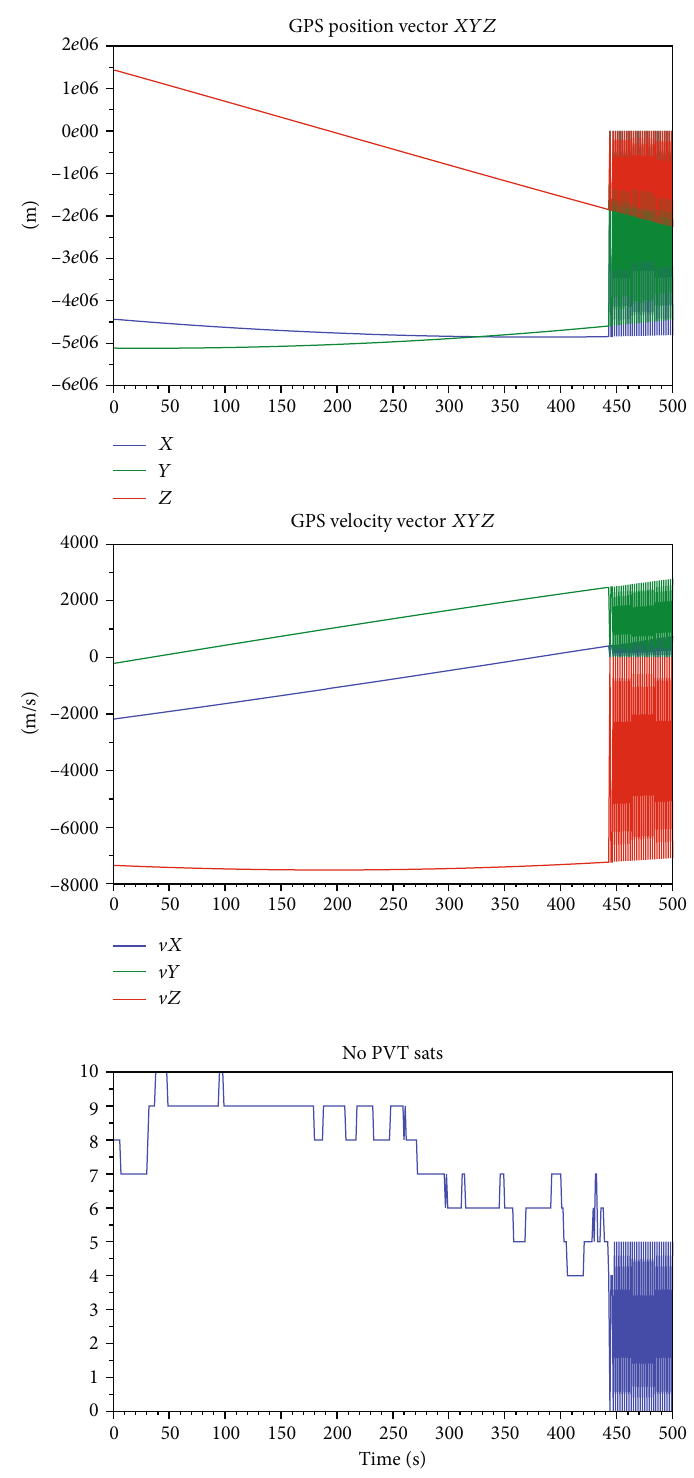
Figure 13: Example of the position and velocity 1-second measurement and development of the number of